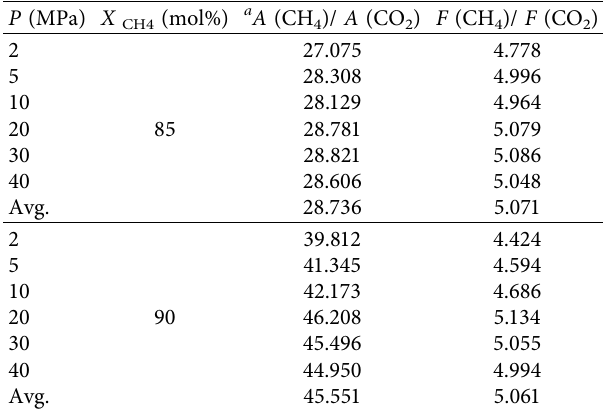
Table 2: The F (CH 4 )/ F (CO 2 ) in ten CO 2 -CH 4 gaseous mixtures at room temperature and pressures up to